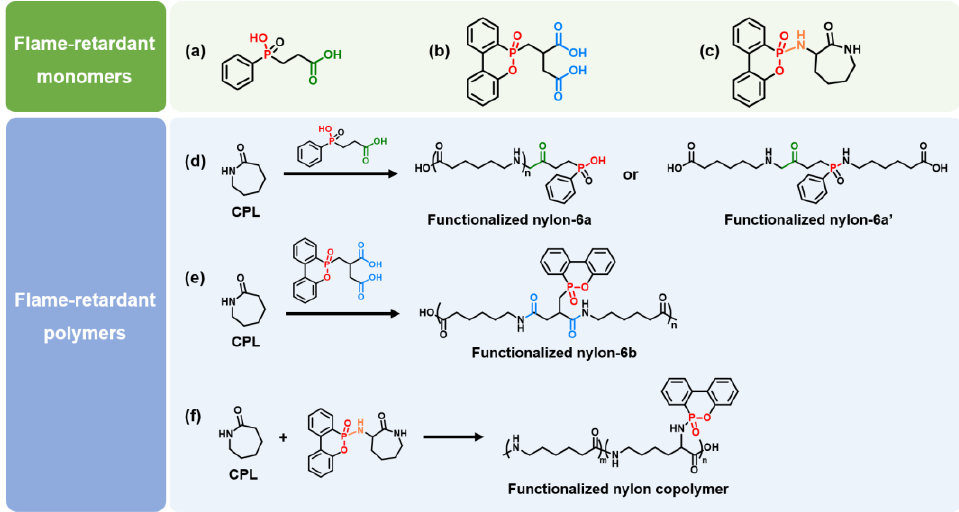
Figure 8. Chemical structures of flame-retardant monomers and polymers of ref. [152,154].